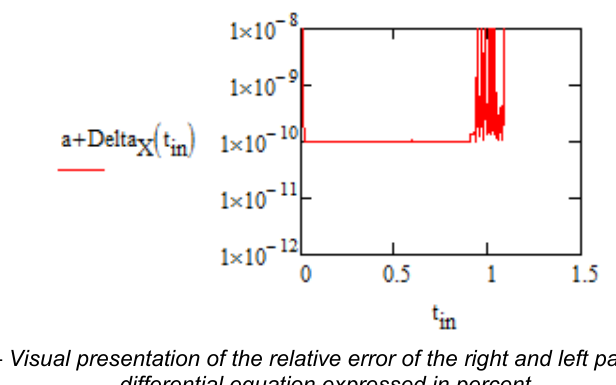
Figure 6 – Visual presentation of the relative error of the right and left parts of the first differential equation expressed in percent (integration interval 0-1.1